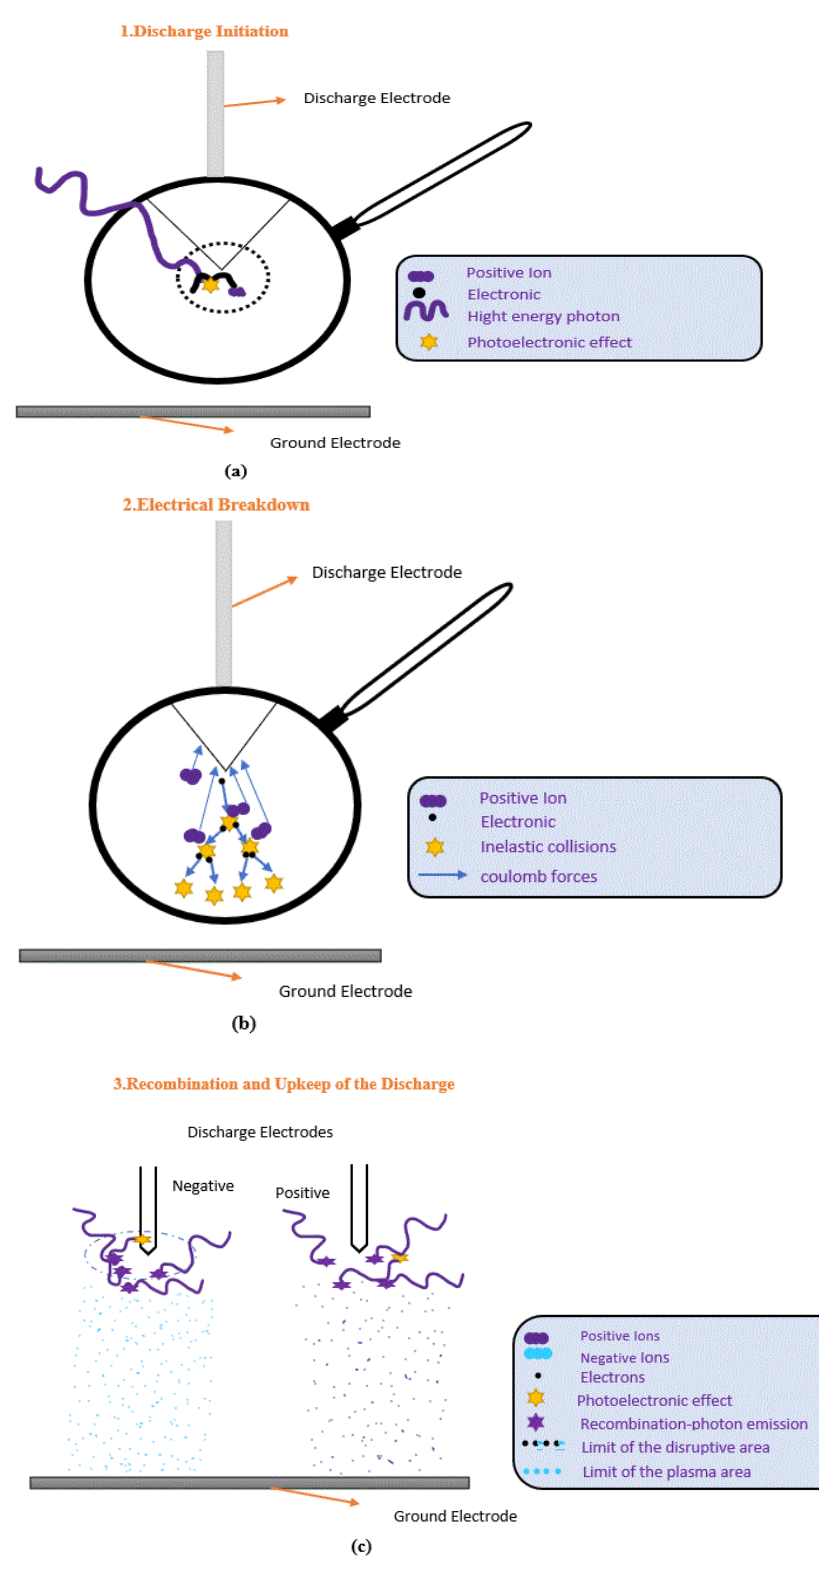
Figure 8. ( a – c ) A corona discharge is a phenomenon that occurs in the air. The conductance and avalanche processes are influenced by the electrode material. Highly conducting materials generate a strong electric field, energizing a large number of free electrons and causing severe corona discharge defects. Copper (Cu) and stainless steel (SS) are two of the most common metals used in MV switchgear because they are both more conductive and more durable than other metals and have a conductivity of 5.96107 siemens per meter (S/m), which is greater than that of SS, which is 1.45106 (S/m). Cu, in comparison to SS, causes more corona discharges in MV switchgear under high-voltage stress. Air, known to have molecules that are electrically neutral, is an insulator. There is an alteration in the molecules whenever energies of high magnitude flow as electrons from an electrode and collide with molecules. Energy is absorbed by the electrons around the atomic nuclei; these electrons transition to high energy levels and separate from their constituent atoms or molecules, leaving a positively charged ion and a dissociated free electron. This avalanche process creates a mix of electrons and ions, as new electrons are created by electrons that have been hit by other electrons [32]. As a consequence, another condition for corona discharges is the presence of light indicators of strong locally applied electric fields that enable persistent discharge into the atmosphere [33]. Moisture plays an important role, such that when a value in air or gas is surpassed, a corona discharge de- velops, resulting in the formation of ozone and ultraviolet, oxides of nitrogen, sound,